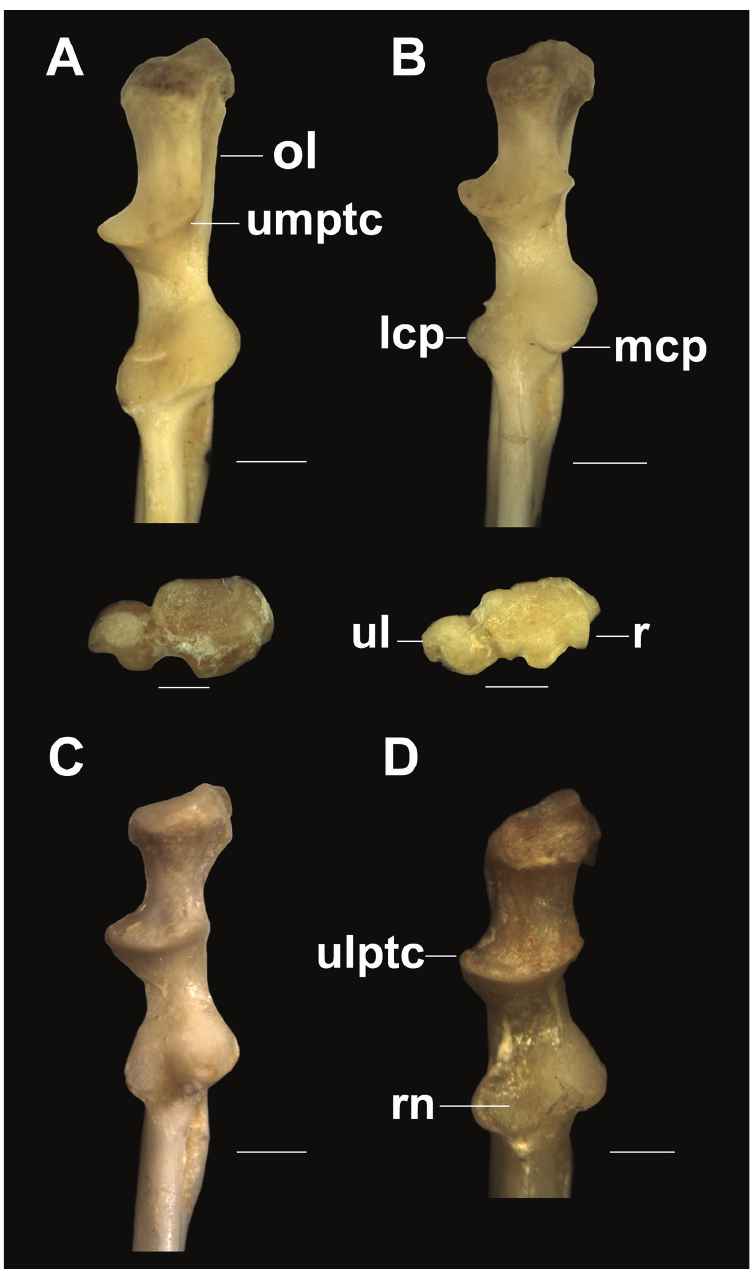
Figure 4. Right ulna, proximal portion in cranial and distal views of radio and ulna. A Tympanoctomys aureus B Tympanoctomys barrerae C Tympanoctomys kirchnerorum D Tympanoctomys loschalchalerosorum . lcp, lateral coronoid process; mcp, medial coronoid process; ol, olecranon; r, radio distal surface; rn, radial notch; ul, ulnar distal surface; ulptc, ulnar lateral proximal trochlear crest; umptc, ulnar medial proximal trochlear crest. Scale bars 1